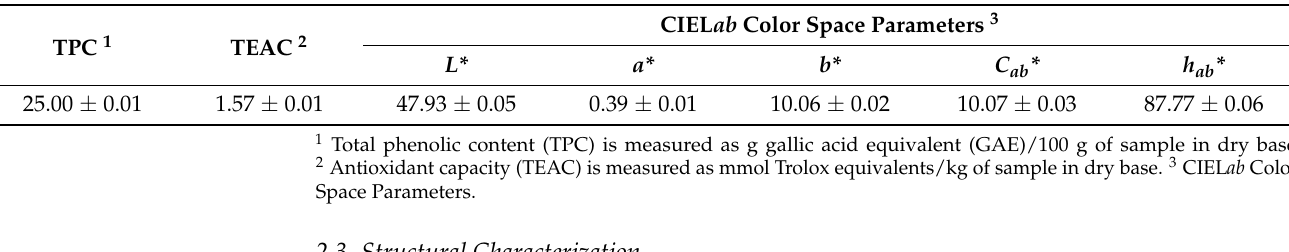
Table 2. Total phenolic content (TPC), antioxidant capacity (TEAC), and CIEL ab color space parame- ters for mucilage extracted from yellow pitahaya fruit peels.